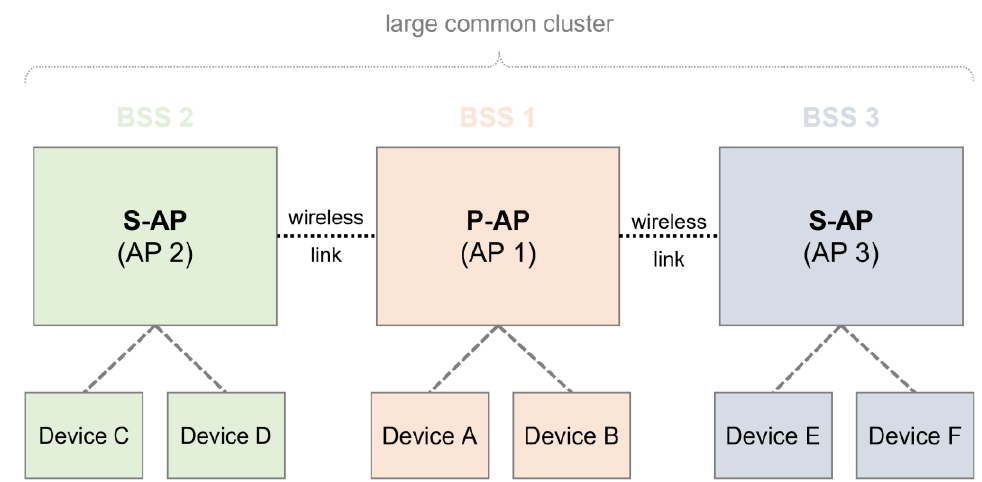
Figure 1. Multi-AP coordination in Wi-Fi 7.